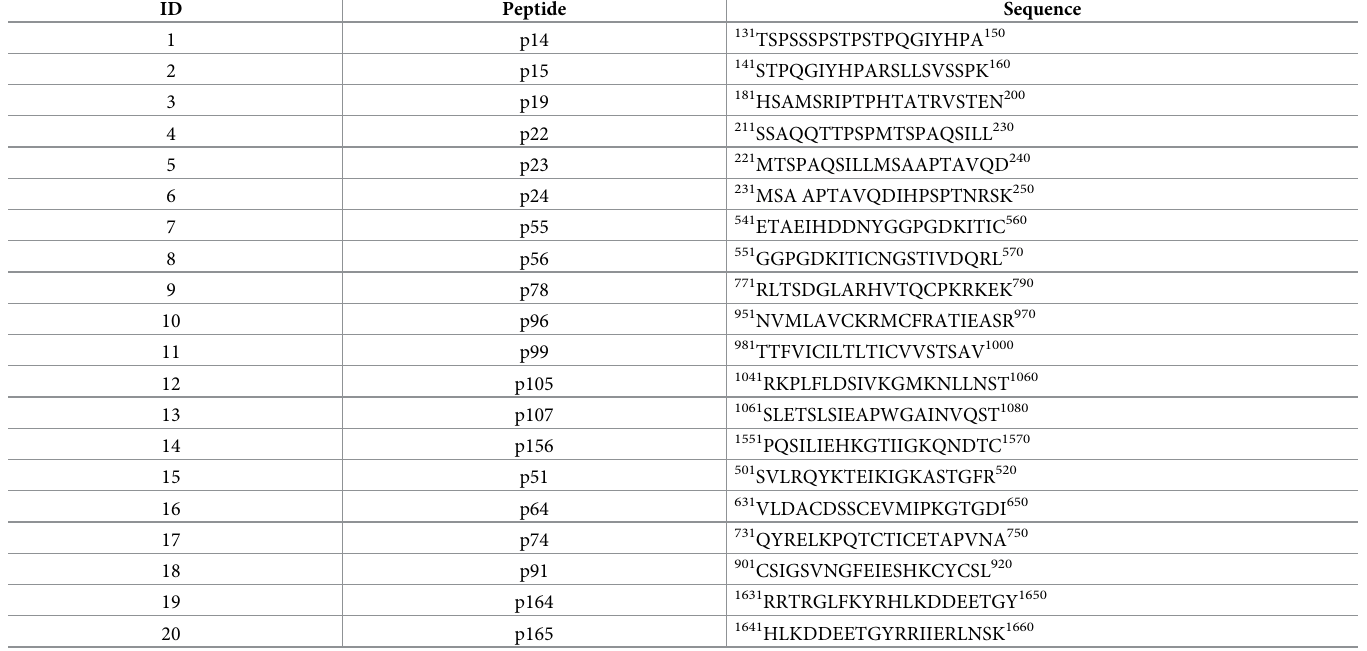
Table 1. Sequences of scan peptides that showed significant reactivity with pooled Turkish sera of CCHFV survivors (1–14) and with control sera (15–20). Five pos- sible epitopes (6, 7, 12, 13 and 14) were selected for further evaluation using a single-amino acid epitope walk analysis. ID Peptide Sequence